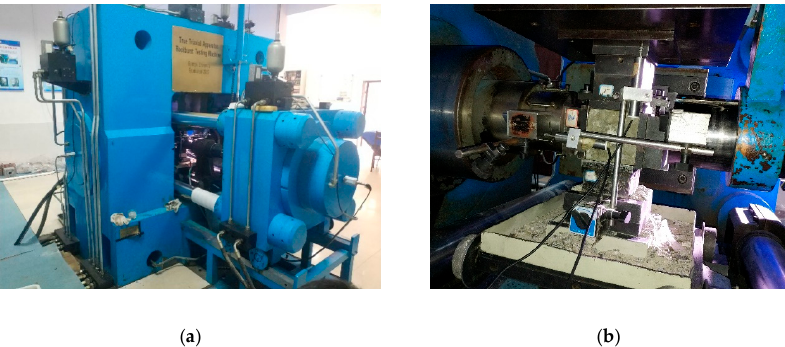
Figure 2. The experimental setup. ( a ) The exterior of the setup; ( b ) the interior of the setup.